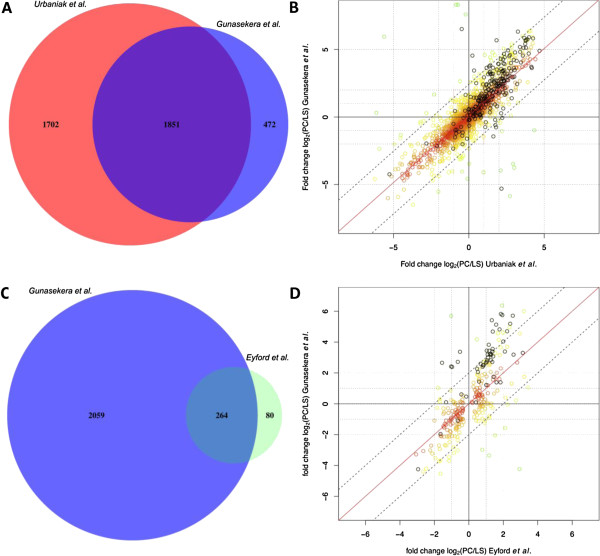
Comparisons of the detection level and the protein abundance changes in three independent studies. (A) Venn diagram displaying proteins detected in Urbaniak et al. and our study. (B) Correlation of protein abundance changes in the two studies. Colors of the circles in the scatter plot indicate correlation between the two studies (red high correlation, green low correlation). Black circles indicate mitochondrial proteins. The Spearman's rank correlation rho=0.82 (p-value < 2.2e-16). (C) Venn diagram displaying proteins detected in Eyford et al. and our study. (D) Correlation of protein abundance changes in the two studies. The Spearman's rank correlation rho=0.7 (p-value < 2.2e-16). For colors of the circles see (B).